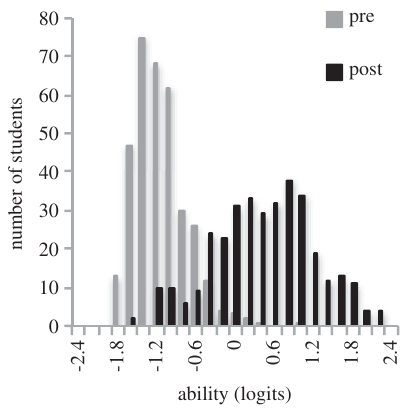
FIG. 26. The pre- and postability histograms for class